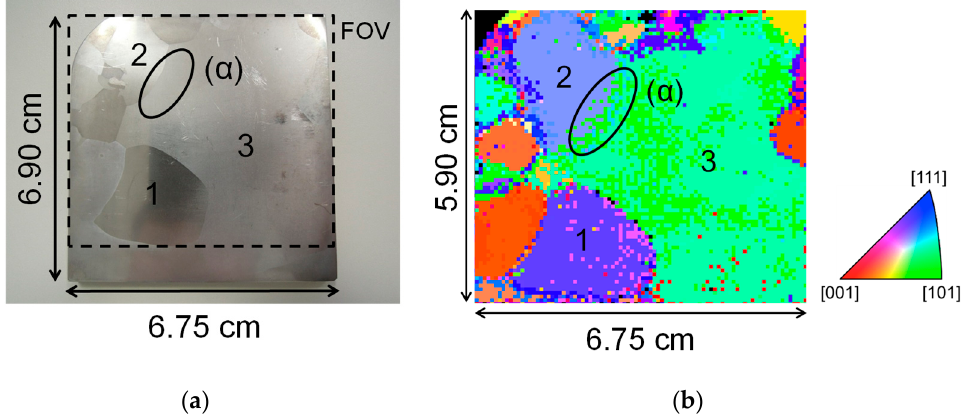
Figure 1. ( a ) Photograph of the Si – steel plate sample. The region surrounded by dashed black lines indicates the field of view (FOV). ( b ) IPF map of the sample, evaluated by Bragg-dip neutron transmission imaging [19]. The number indicated in the figure indicates the number of grain. The figure is reproduced with permission of the International Union of Crystallography from reference [19]. Table 1. Crystal orientations [ uvw ] along neutron transmission direction for Grains 1, 2 and 3. Grain